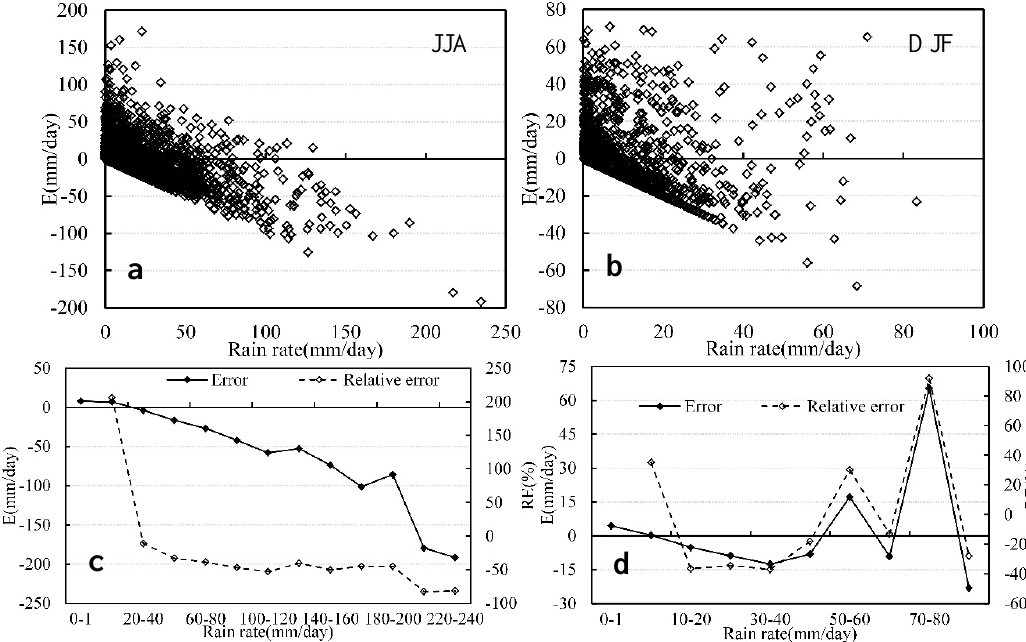
Figure 7. The relations between precipitation difference and rain rate at daily scale for TRMM 3B42RT,